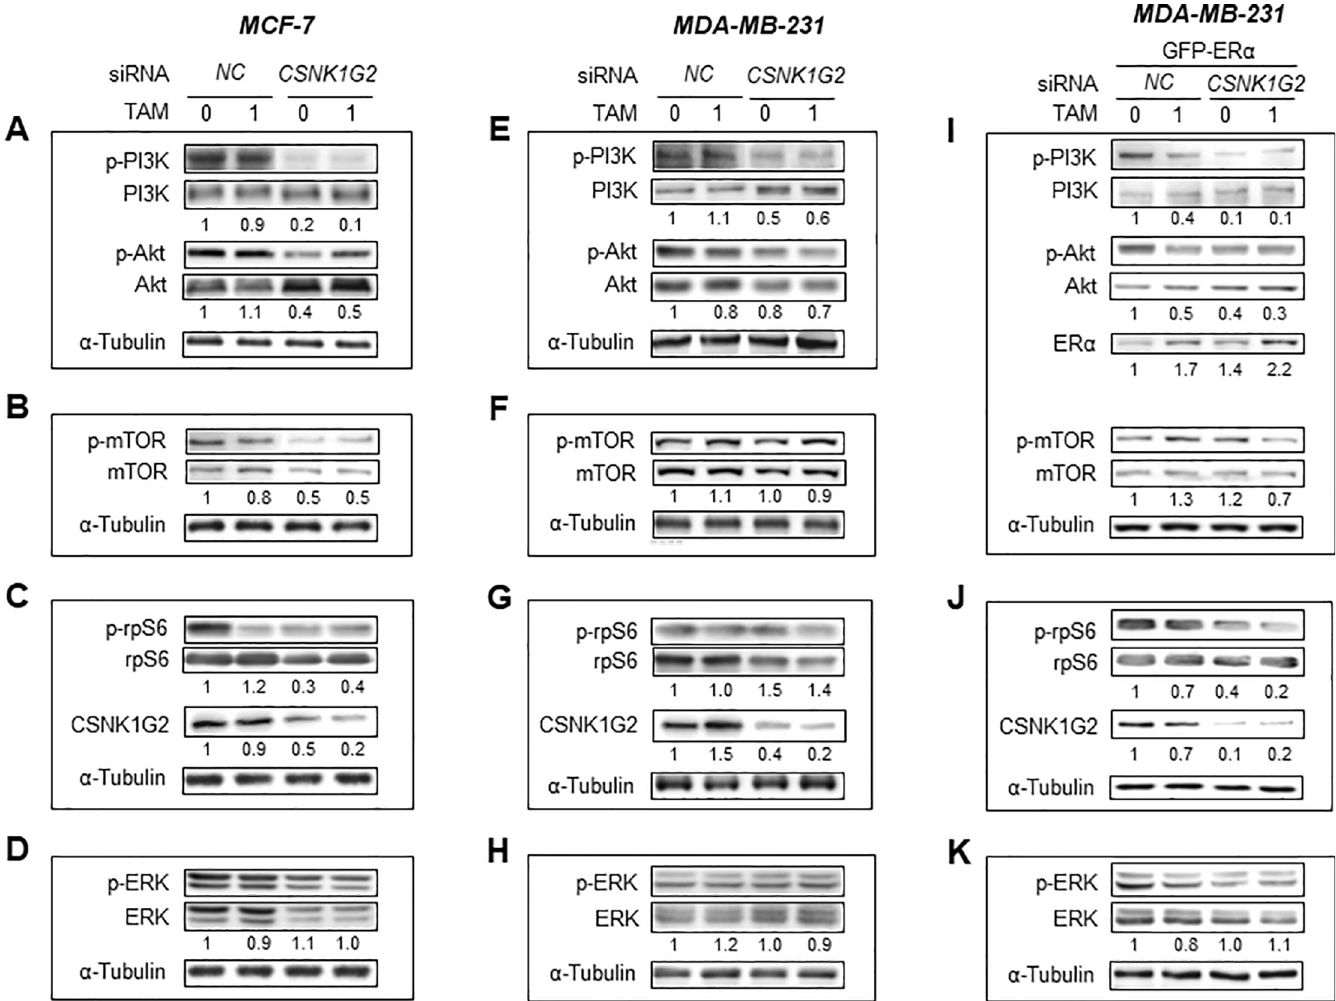
Fig 5. CSNK1G2 effect on PI3K/AKT/mTOR/S6K and ERK signaling in human breast cancer cells. Immunoblots for PI3K/AKT/mTOR/S6K and ERK signaling- associated proteins in (A-D) MCF-7, ( E-H) MDA-MB-231, and (I-K) GFP-ER α -overexpressed MDA-MB-231 cells. Western blotting analysis from the breast cells transfected with control siRNA ( NC ) or CSNK1G2 siRNA ( CSNK1G2 ) were performed after treatment with vehicle or 1 μ M TAM for 24 h. Protein expression levels based on individual bands of phosphor were compared to expression levels of α -tubulin and/or pan (total) protein. Each value under the blots indicates relative protein expression levels determined by densitometric analysis. Data are presented as mean (SD); n =